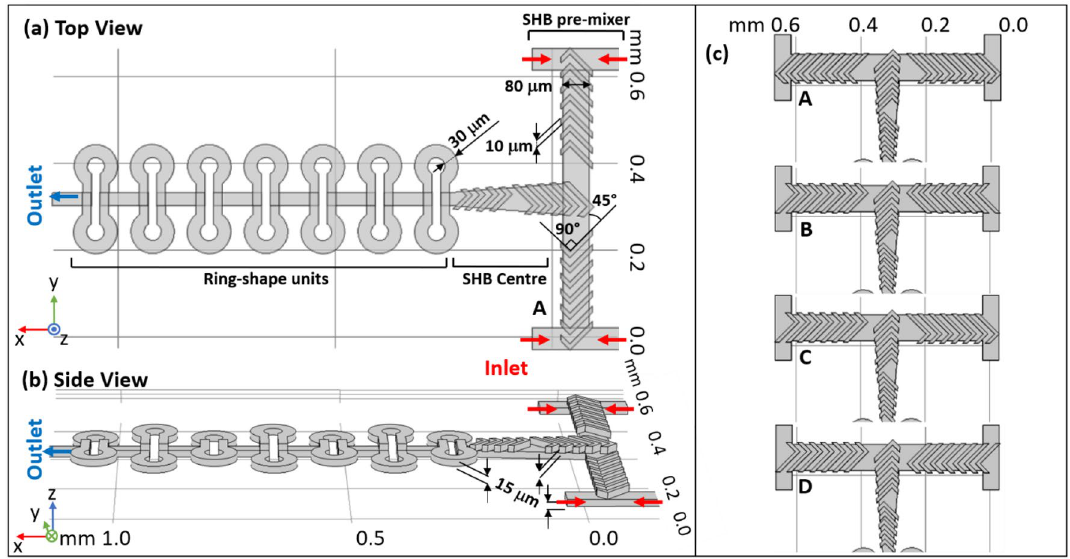
Figure 1. The structure details of the complete mixing compartment studied in this paper in top (a) and side views (b) . The mixer is composed of three zones: SHB pre-mixer, SHB center channel and ring-shape units. The mixer region is built out of two separate layers: the top one contains the SHB ridges and the bottom one the double-T pre-mixer channel. Several ring-shaped units are also combined with the main channel on the bottom layer during fabrication. (c) The four different arrangements of the SHB including the one shown in (a,b) , for a total of four SHB designs for the double T structure, marked A, B, C and D. The 3D sketches shown on this figure were made with the SOLIDWORKS 2020 software (http:// www. solid works.